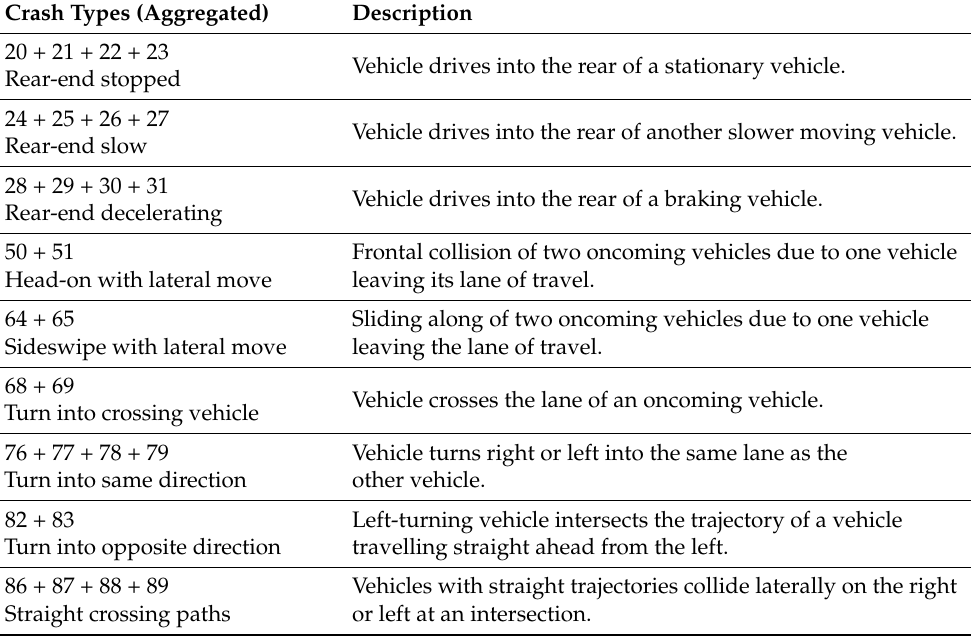
Table 3. Description of the aggregated crash types within the CISS database according to [16]. Crash Types